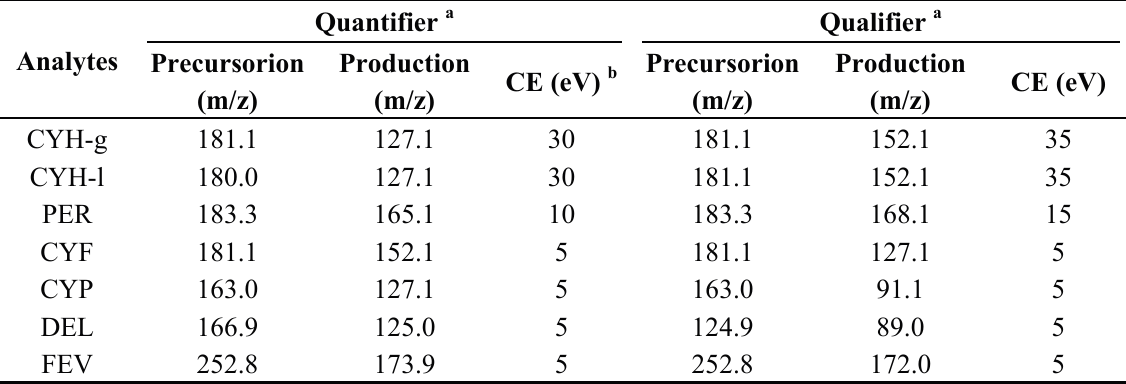
Table 6. Mass spectrometry settings for GC-MS/MS analysis of pyrethroids in MRM mode. Quantifier a Qualifier a Analytes Precursorion Production Precursorion Production CE (eV) b CE (eV) (m/z) (m/z) (m/z) (m/z) CYH-g 181.1 127.1 30 181.1 152.1 35 CYH-l 180.0 127.1 30 181.1 152.1 35 PER 183.3 165.1 10 183.3 168.1 15 CYF 181.1 152.1 5 181.1 127.1 5 CYP 163.0 127.1 5 163.0 91.1 5 DEL 166.9 125.0 5 124.9 89.0 5 FEV 252.8 173.9 252.8 172.0